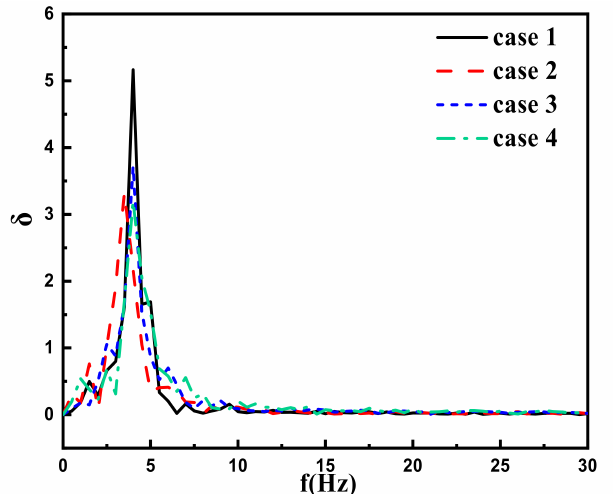
Figure 13. The spectra of POD mode coefficient (Mode 1) for the smooth cylinder and the dimpled cylinder with different